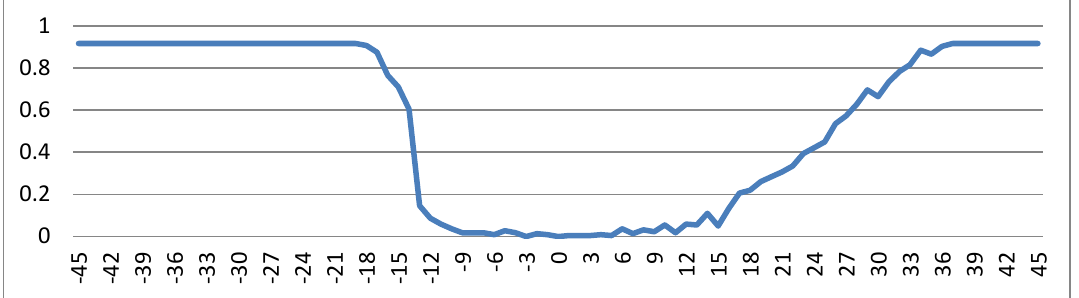
Figure 13. Character error rate vs. the degree of page slant as performed by a commercial OCR system.